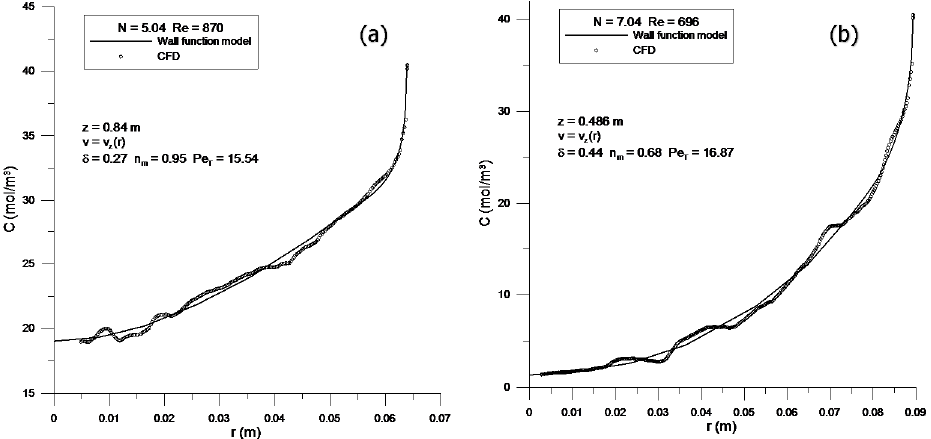
Figure 10. Results for three-parameter wall function model using D T ( r ): ( a ) N = 5.04, Re = 870; ( b ) N = 7.04, Re = 696. Single bed depth.